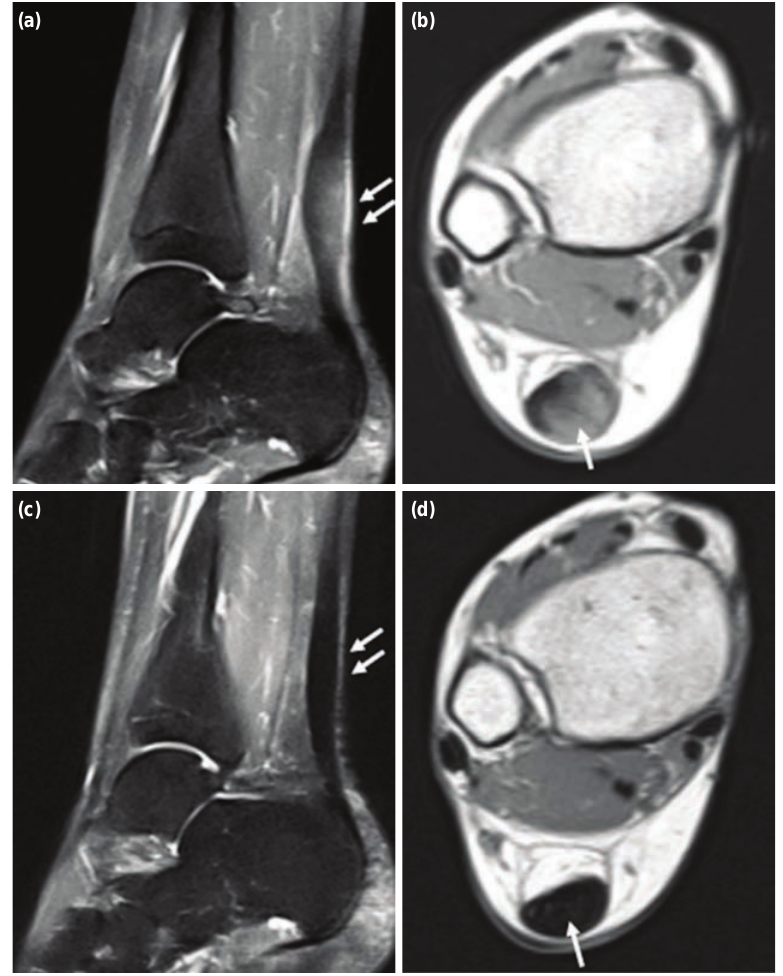
(a) Sagittal short tau inversion recovery (STIR) MR image and (b) axial T2W MR image of the right ankle showing non-insertional Fig. 2: Achilles tendinosis with fusiform thickening and hyperintense signal of the Achilles tendon (white arrows). (c) Sagittal STIR MR image and (d) axial T2W MR image showing the Achilles tendon resuming its normal signal intensity and appearing less thickened compared to previous study (white arrows) at six months following multiple needling and a five-weekly injections of PBSCs plus